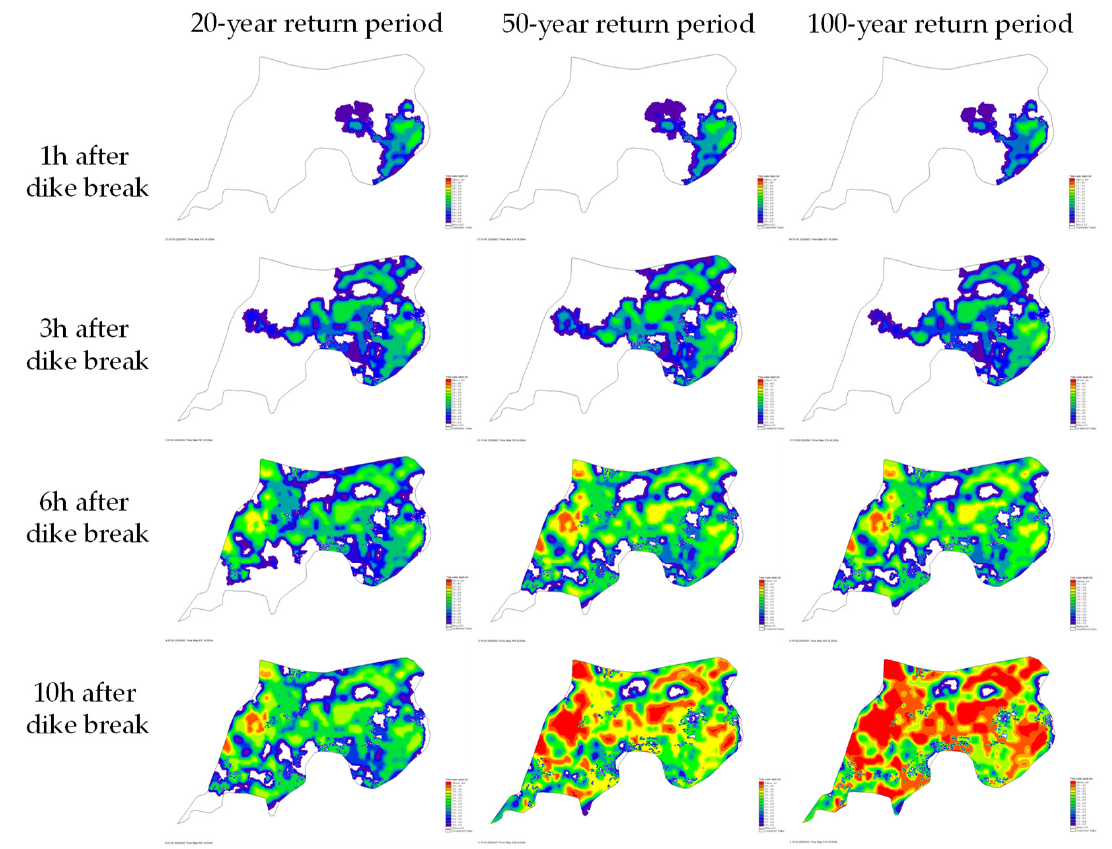
Figure 7. Evolution processes of floodwater inNo.18 polder area.